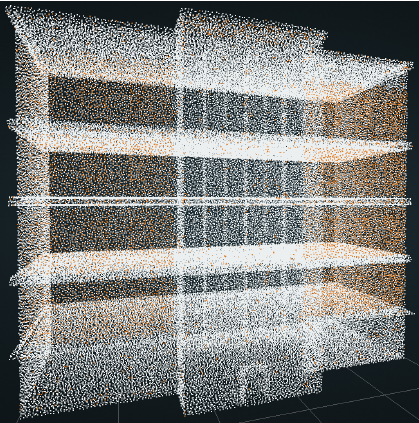
Figure 7. The change detection result of the two models shown in Figure 6. The change is represented by orange